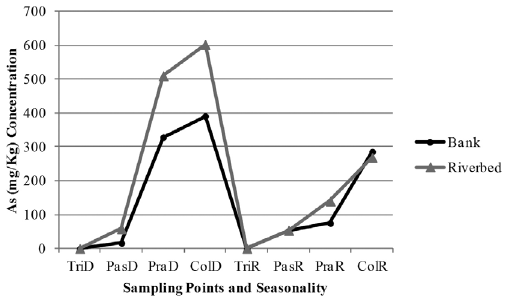
Figure 2. Longitudinal variation for As (mg/Kg)